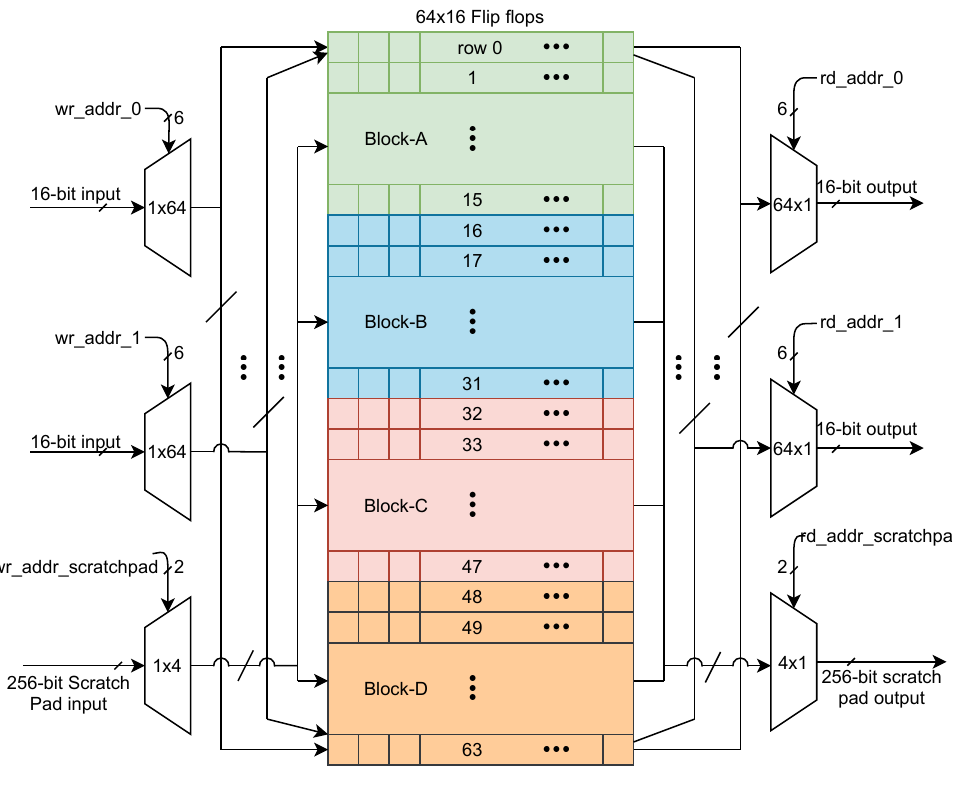
Figure 1. Register File